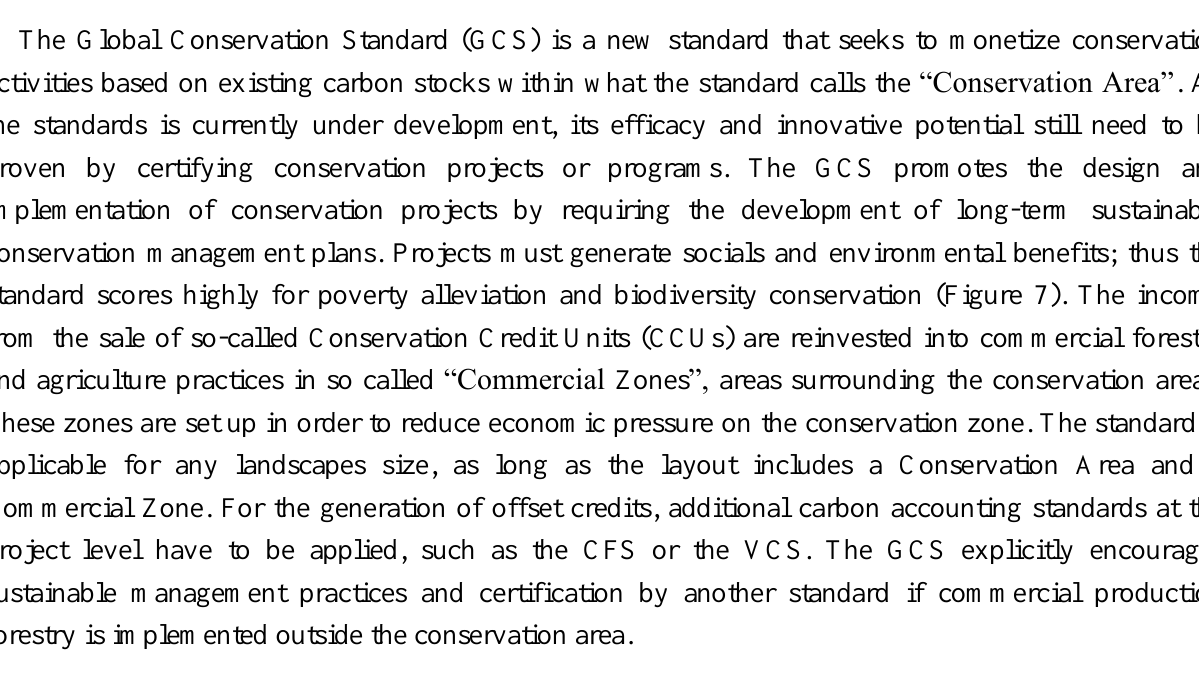
Figure 7. Summary of Global Conservation